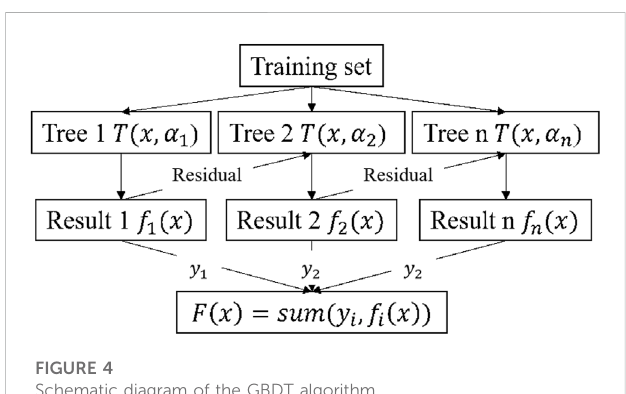
FIGURE 4 Schematic diagram of the GBDT